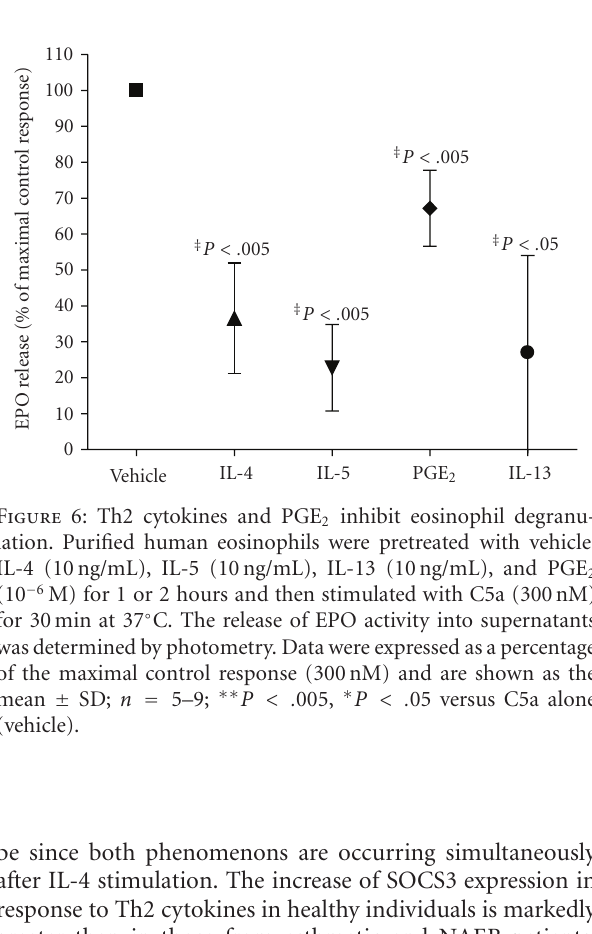
Figure 5: PGE 2 stimulation of SOCS3 mRNA expression. Purified eosinophils from healthy donors were cultured with 10 − 4 M of PGE 2 for up to 120min (a), and with increasing doses of PGE 2 at 120min (b), and SOCS3 mRNA was measured by real-time quantitative PCR. The results are expressed as a fold induction relative to untreated eosinophils, and significant di ff erences are indicated. Data represent the geometric mean ± SD from four individuals, and each measure was performed in triplicate.